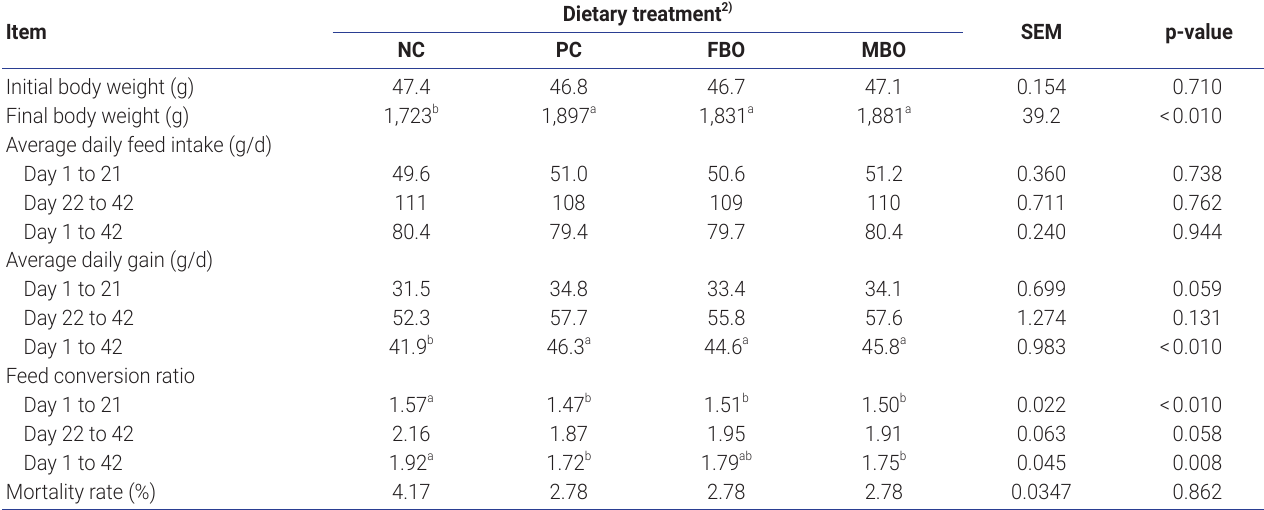
Table 3. Growth performance of broiler chickens on day 21 and day 42 1)